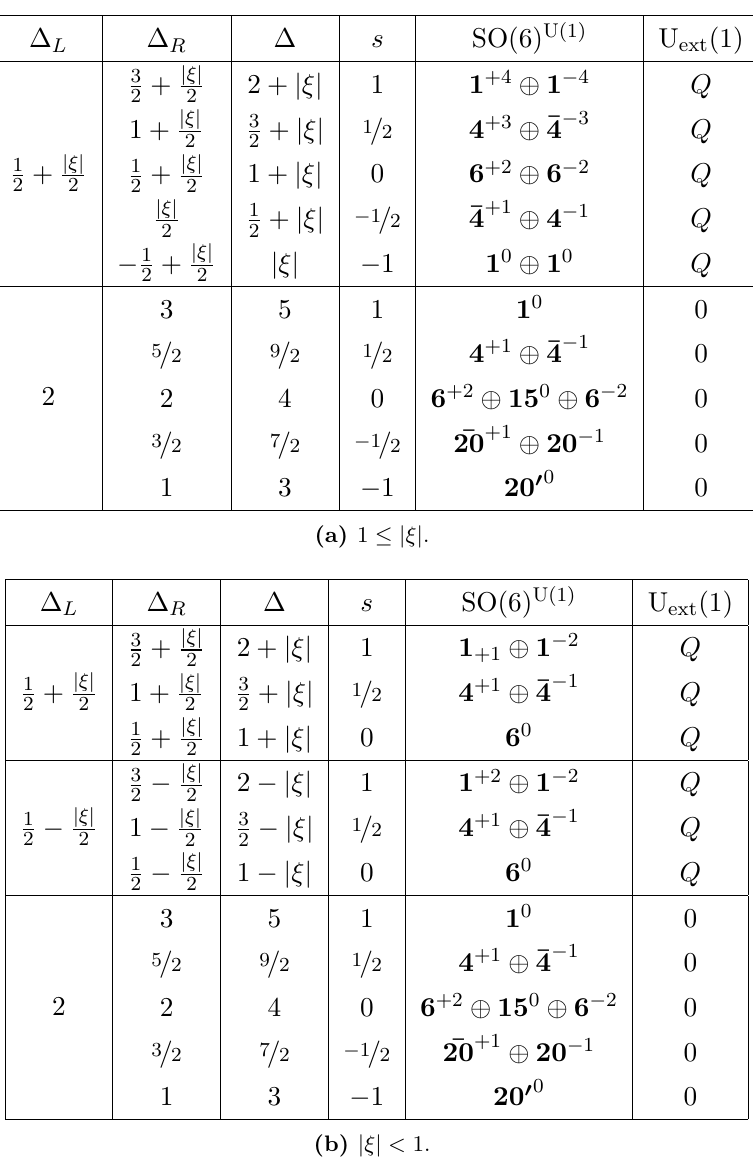
1 ; 1) solutions with diagonal embedding (2.21b). The gauge j SO(2 ; 1) for (cid:24) = 1 and GL(6) SO(2 ; 2) (cid:2) j j (cid:2)